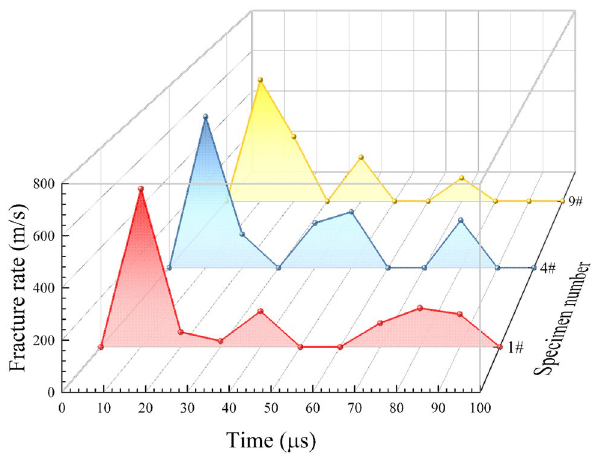
Figure 6. The fracture rate–time curve of tuff specimen during the whole